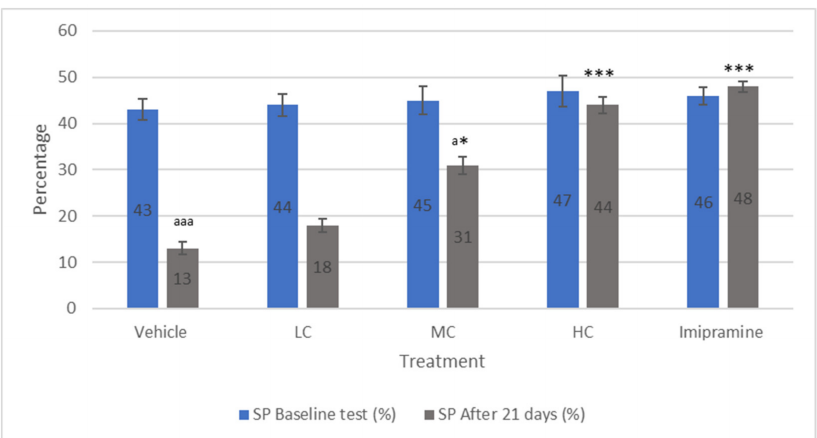
Figure 2. The changes in percentage sucrose preference test due to crocin and imipramine. Data were given as mean and standard error of mean. Each group had eight animals. Statistical analysis was performed by one-way analysis of variance (ANOVA) and post-ANOVA Tukey’s test; * p < 0.05, and *** p < 0.001 when compared to vehicle; a p < 0.05, and aaa p < 0.001 when compared to baseline percentage sucrose preference results of the same group; LC—low dose of crocin; MC—medium dose of crocin; HC—high dose of